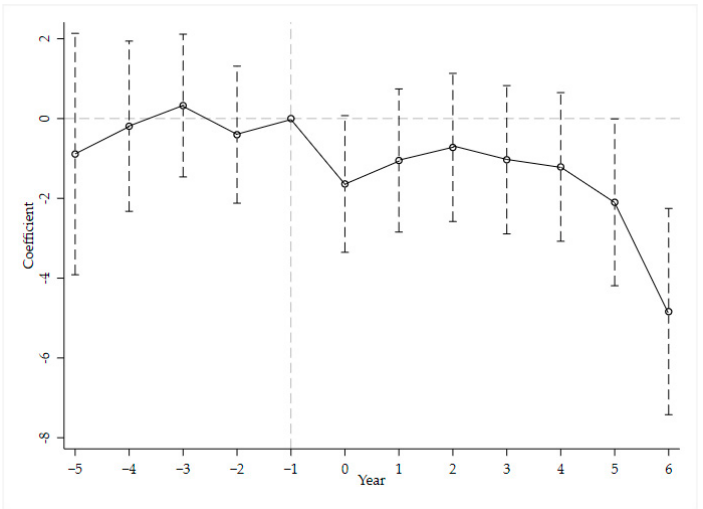
Figure 1. Dynamic effect of smart city policy on PM 2.5 . Note: The solid line in the figure plots the estimated value of the smart city pilot policy, and the dashed line indicates the 95% confidence interval.